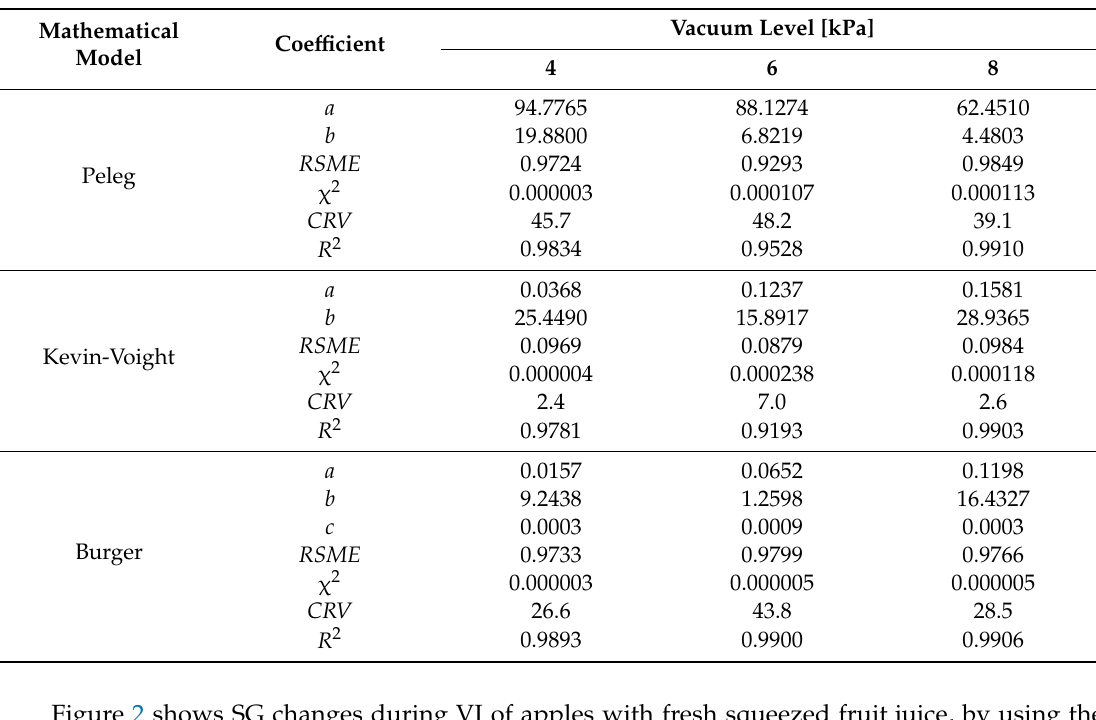
Table 5. Statistical factors in mathematical models fitting the experimental data of SG changes during VI of apples at varied vacuum pressures of 4, 6, and 8 kPa using distilled water as the impregnating liquid.